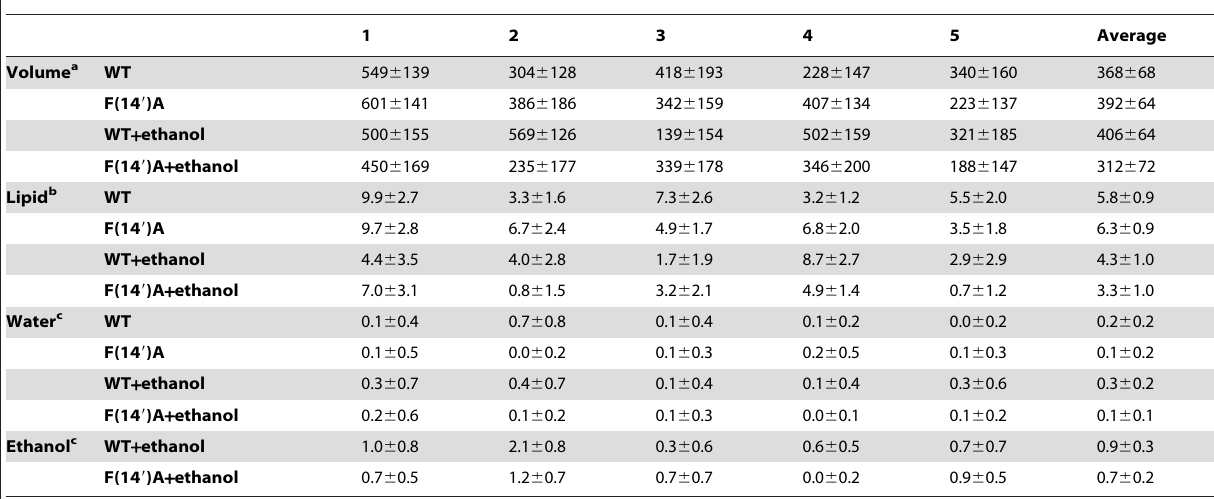
Table 1. Intra-subunit cavity